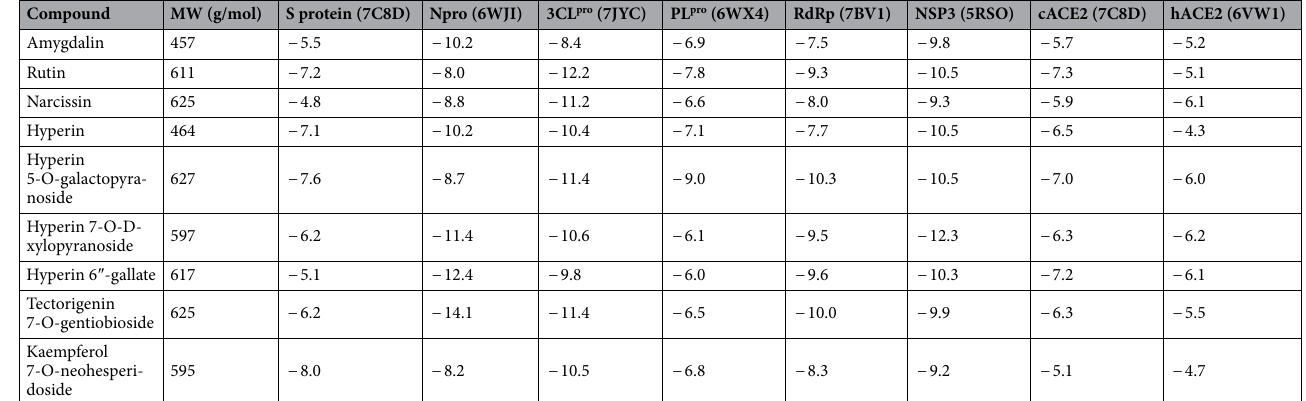
Table 1. Compounds suggested by ensemble docking to interact with multiple SARS-CoV-2 proteins and human/cat ACE2, as well as their best Glide XP docking scores (kcal/mol) from ensemble docking. The PDBID of each protein model was provided in parenthesis in the table header.